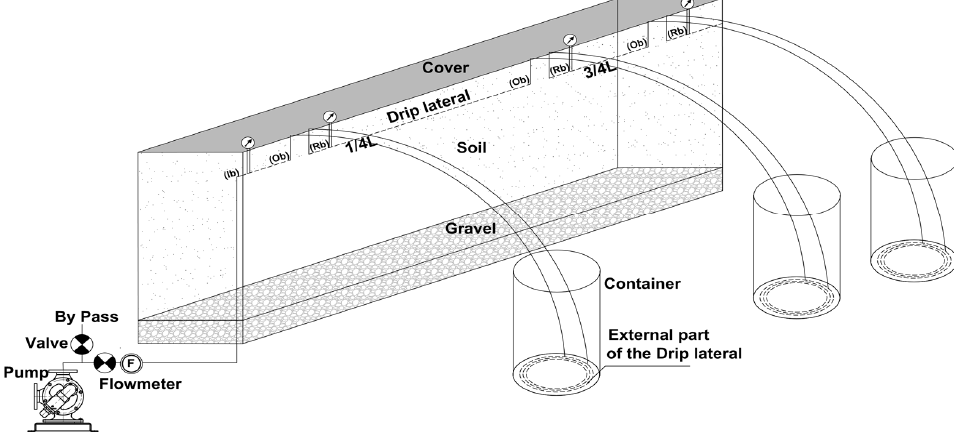
Figure 2. Schematic view of the experimental setup. Table 1. Soil physical and hydraulic